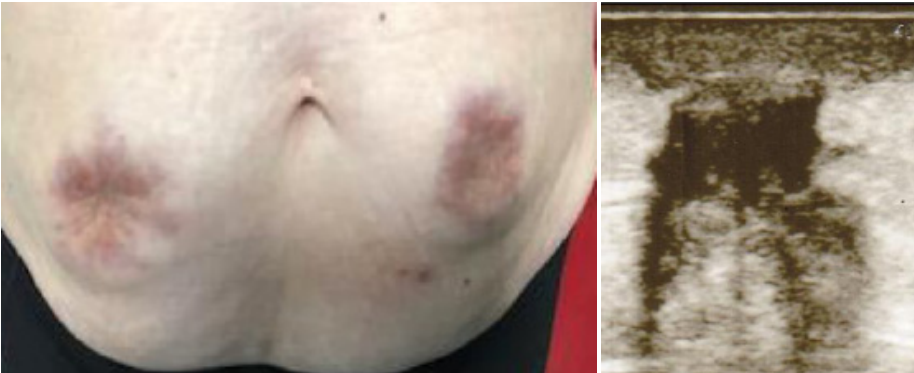
Figure 1. Two major LH swellings were evident at the two sides of the navel markedly protruding from the cutaneous plane ( left panel). The central areas of both LH lesions were easily identified by sight and touch as umbilicated, hyperchromic, and clefted. In the ( right panel), ultrasound scans of lipo-hypertrophic area are also provided: the thickening of the dermis is clearly visible together with the central, colliquative area.